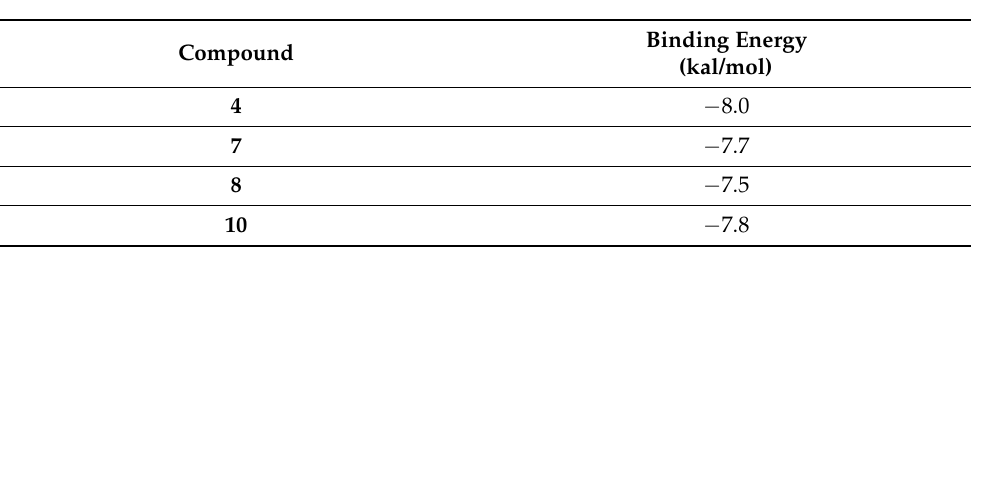
Table 1. Binding Energy for compounds 4, 7, 8 and 10 in the β 1-adrenergic receptor (PDB code